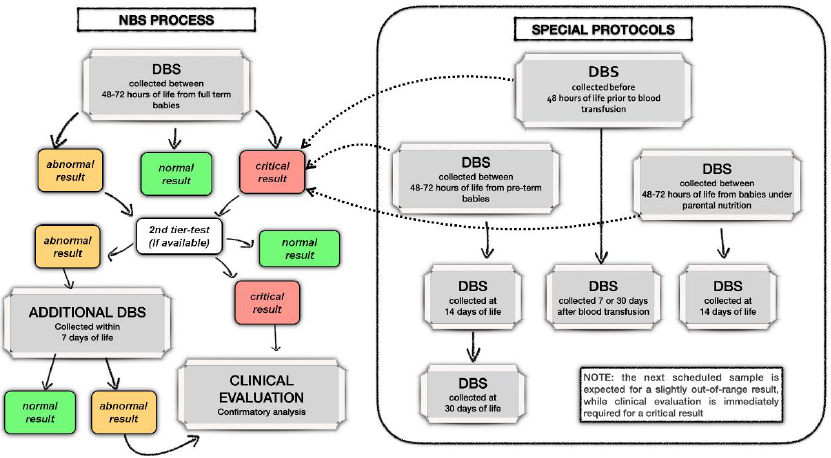
Figure 2. NBS flow